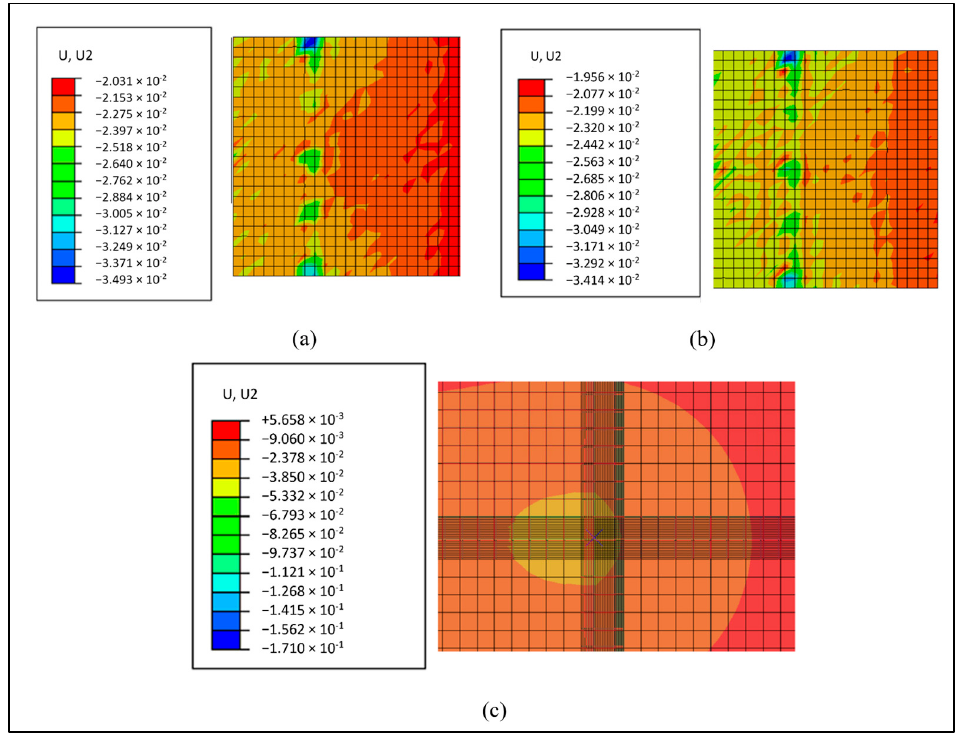
Figure 14. Vertical deflection contours on the transparent polycarbonate layer for ( a ) SP10, ( b ) SP16, and ( c ) typical pavement model after 2.250 s. and ( c ) typical pavement model after 2.250